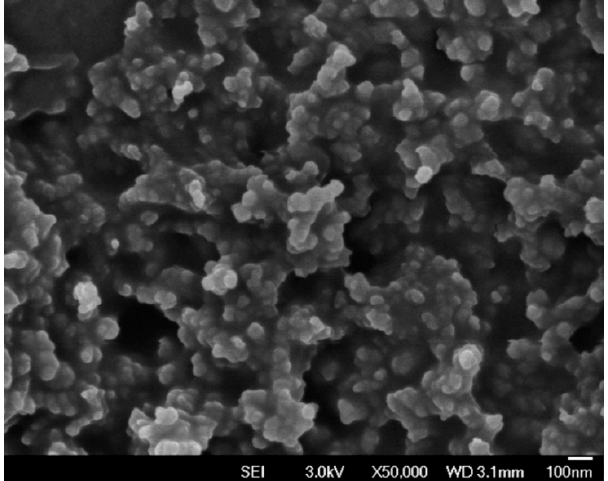
Figure 5. FE-SEM image of the graphite sensor window surface of a SPCE (without ZnO).